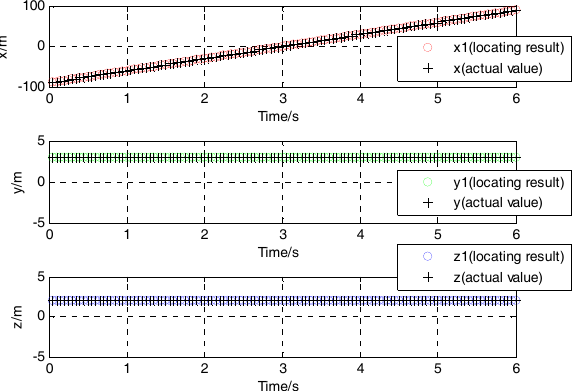
Figure 8. The position of the moving ferromagnetic target considering angular rotation.